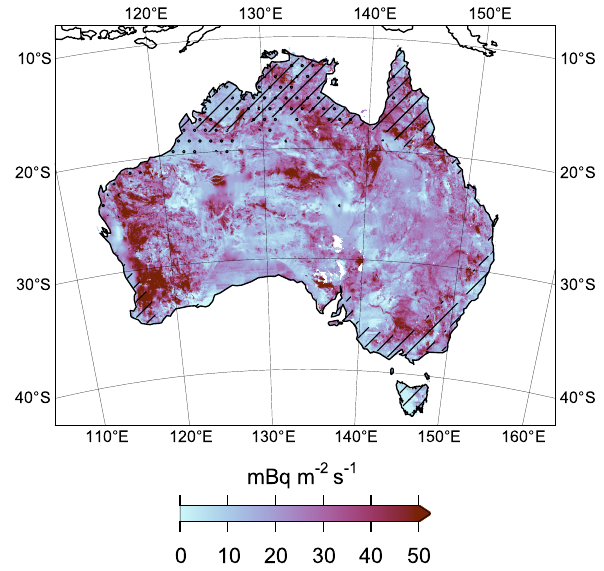
Fig. 7. Mean radon-222 flux density over the period July 1979–June 2010, the area-weighted mean is 23.4 ± 2.0mBqm − 2 s − 1 . The hatched region shows where the topsoil is wet enough to reduce radon flux by 25% from its maximum value for two or more months of the year and the stippled region shows where the topsoil is dry enough to reduce radon flux by 25% from its maximum value for two or more months of the